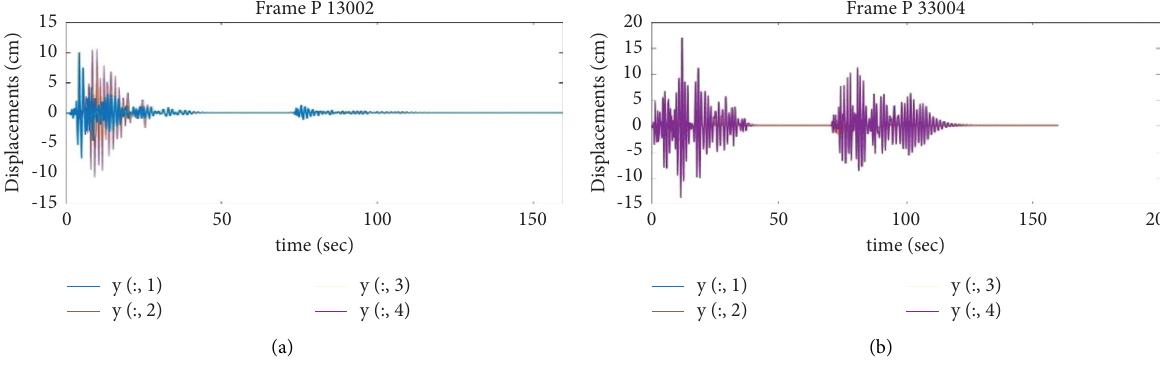
Figure 11: Time history response of 4-story model (RC) under SS: (a) Chalfant Valley. (b)